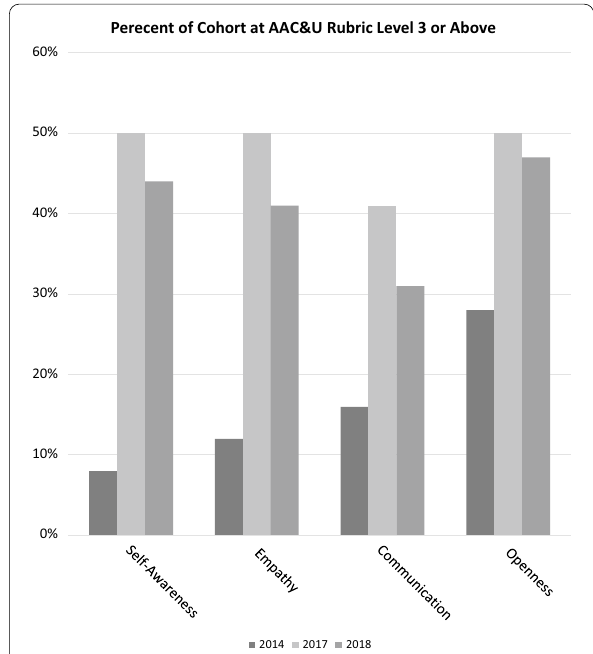
Fig. 4 Cohort comparison of building block attributes of intercultural